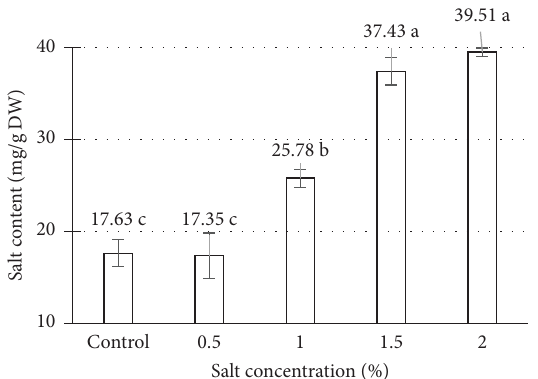
Figure 1: Efect of salt concentration during blanching on the salt content in small